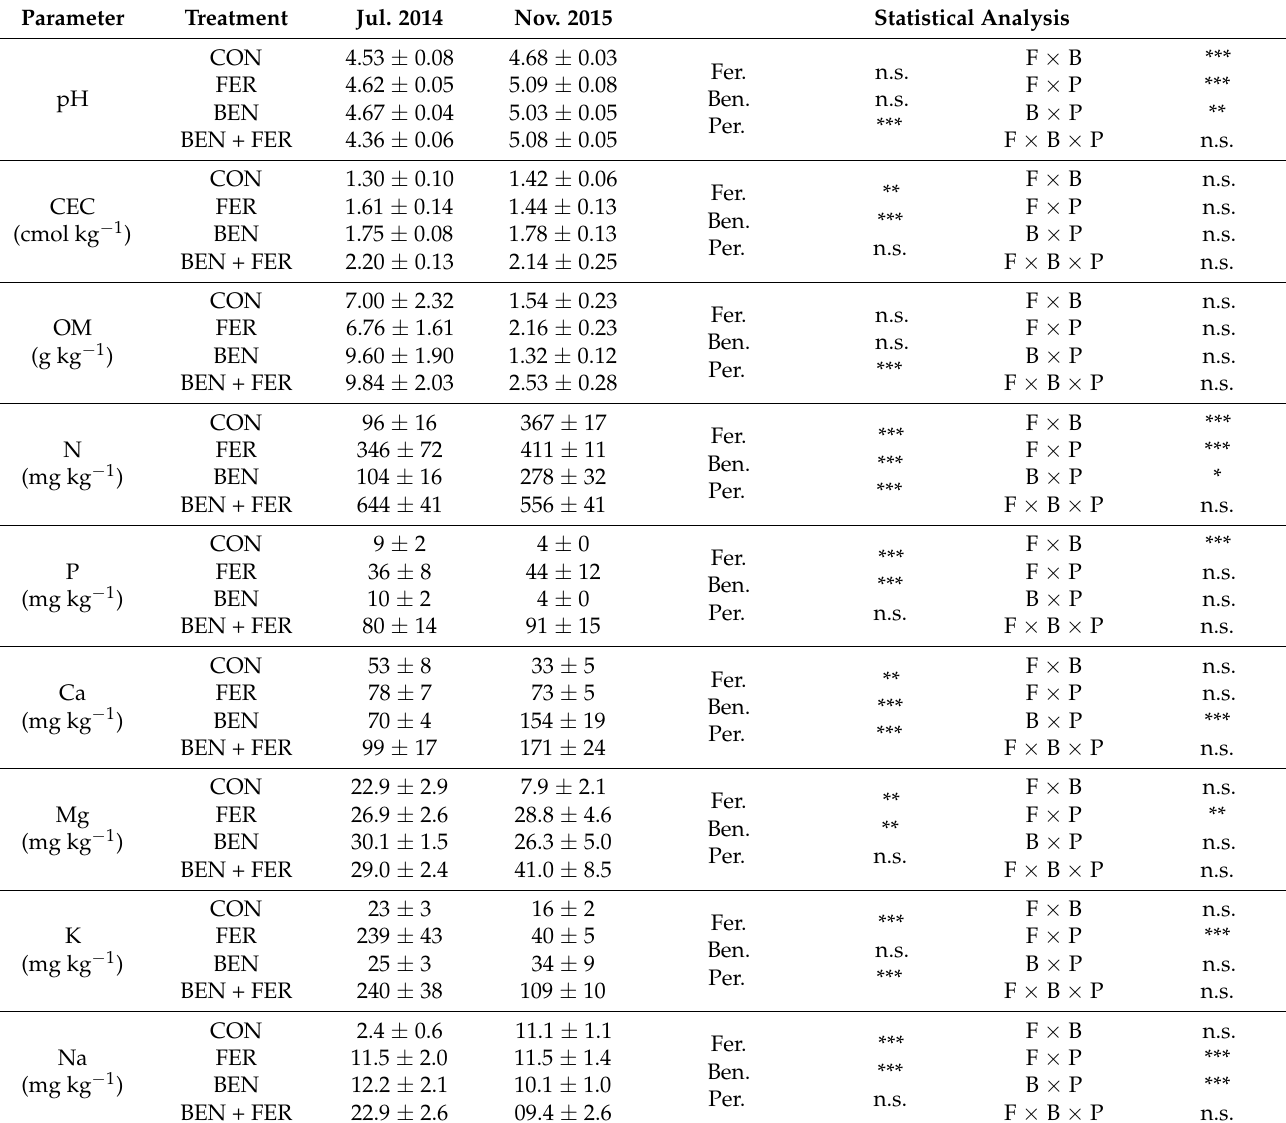
Table 2. Texture Chemical properties (pH, CEC, OM, and elements) of soils in the four treatments (mean ± SE, n = 9) sampled in June 2014 and December 2015. Asterisks indicate significant differences by three-factor ANOVA. * = p < 0.05, ** = p < 0.01 and *** = p <